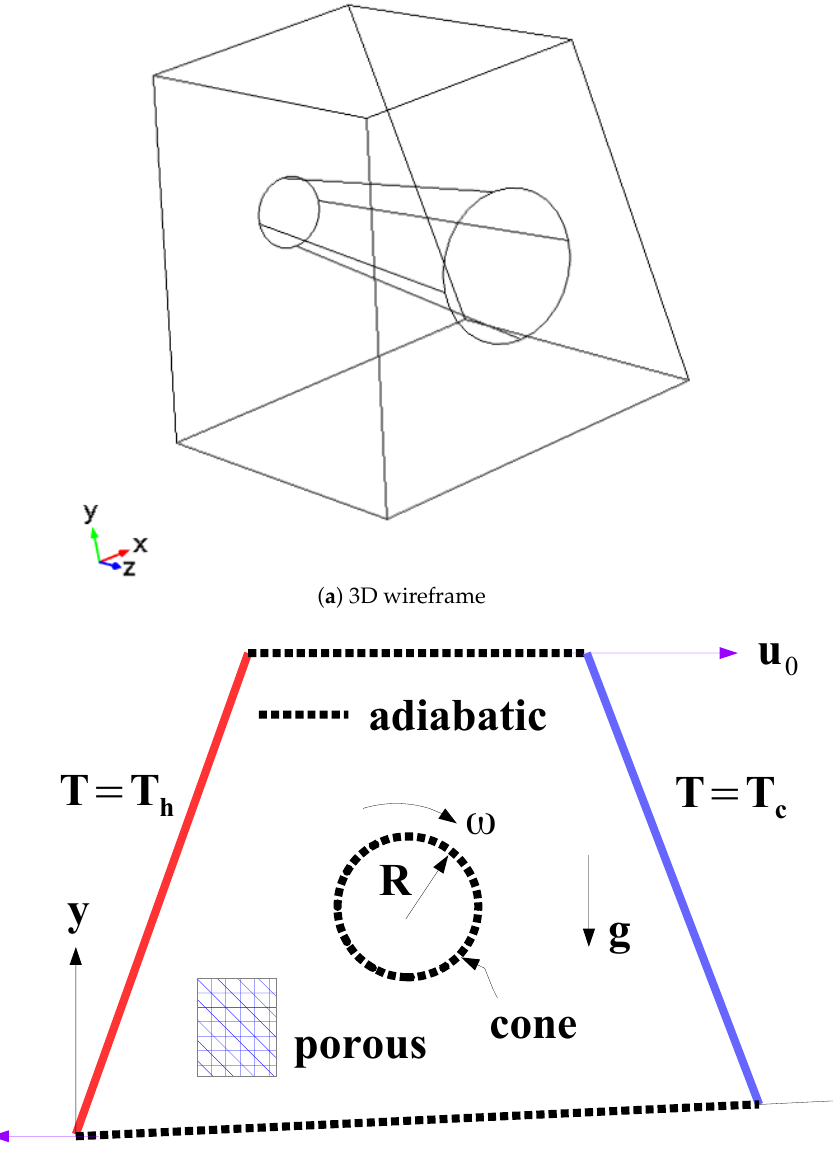
Figure 1. Schematic description of the physical model ( a ) 3D ( b ) 2D with boundary